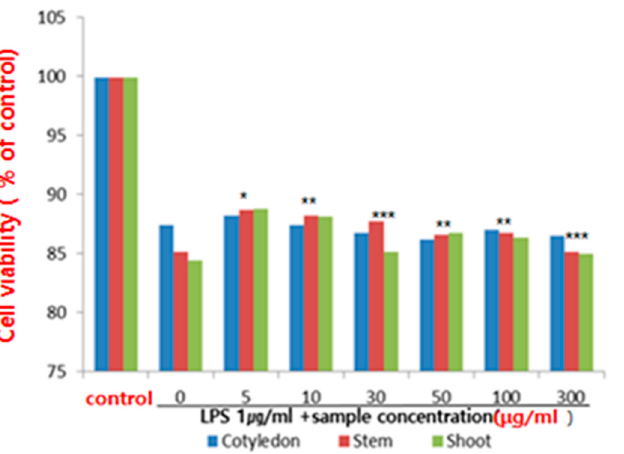
Figure 2. Effect of ethanol extract of the ice plant ( M. crystallinum ) on cell viability in lipopolysac- charide (LPS)-treated RAW 264.7 cells (* p < 0.5, ** p < 0.01, *** p < 0.001 compared to the control by ANOVA).